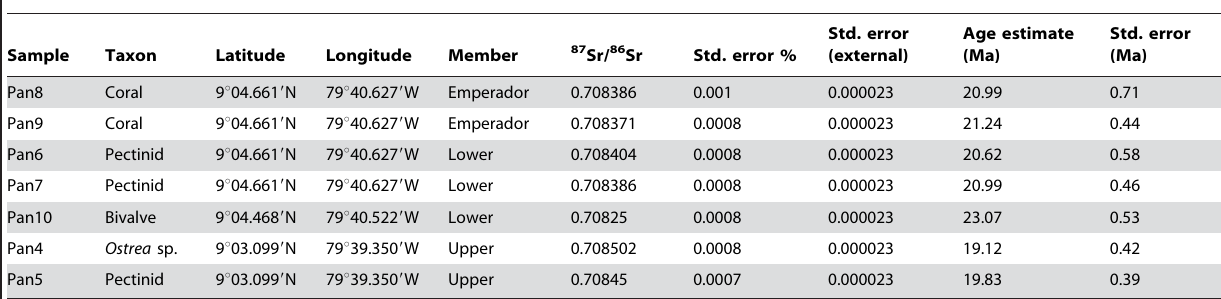
Table 2. Sr chemostratigraphic analyses of the Cuelbra Formation, Panama.